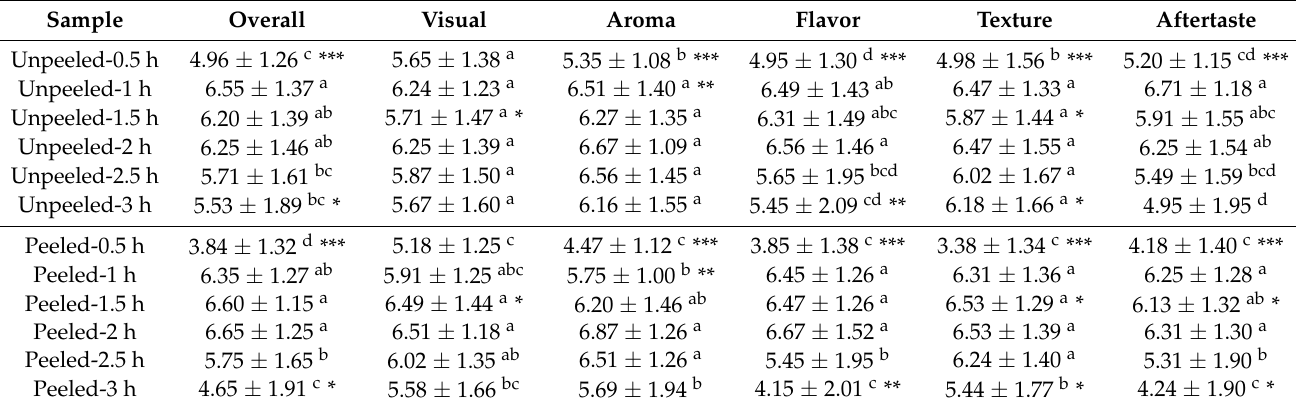
Table 4. The average value of consumer acceptance of the sensory quality of sweet potato with different roasting treatments. Sample Overall Visual Aroma Flavor Texture